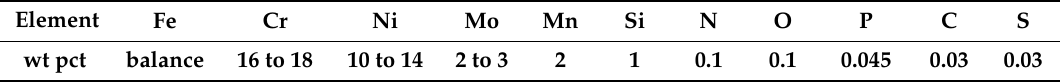
Table 1. Chemical composition of SS316L powder and the substrate.